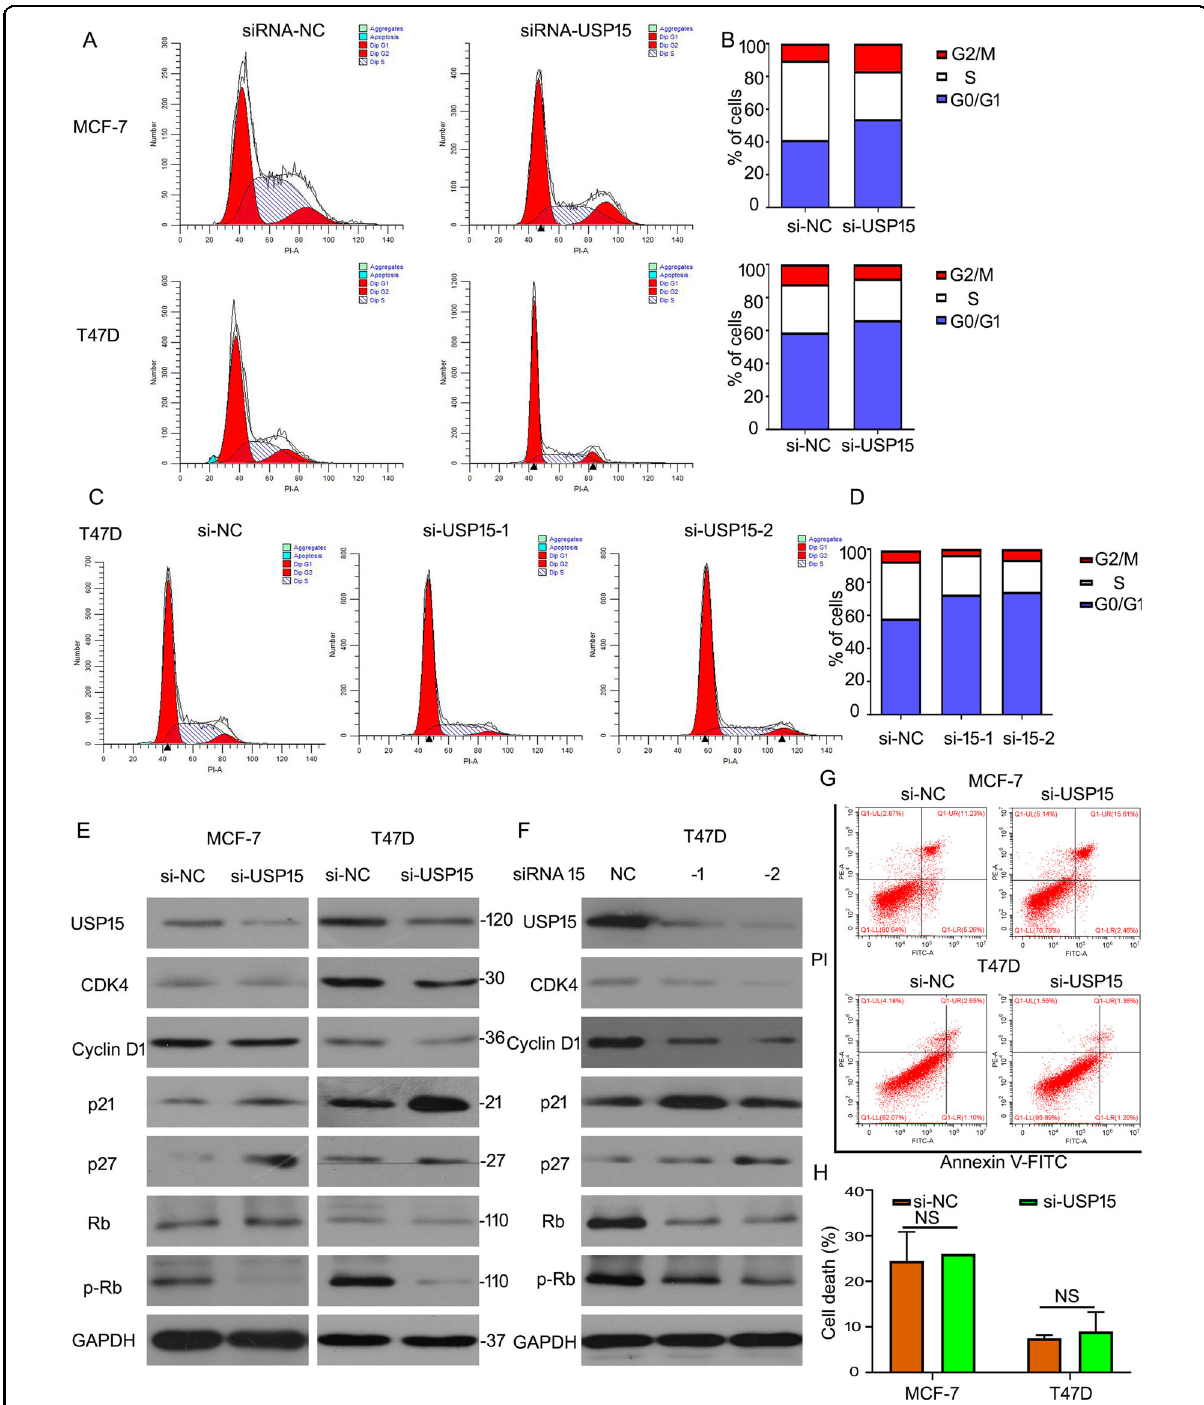
Fig. 2 USP15 deletion triggers cell cycle arrest in ER α + BC cells. A , C Cells were exposed to USP15 siRNA targeting different sets for 48 h, subjected to FACS for cell distributions. B , D The percent of cell number on each phase was showed. E , F Cells were treated with USP15 siRNA, proteins were collected for USP15, CDK4, Cyclin D1, Rb, p-Rb, p21, and p27 expression. GAPDH was as a normalizer. G The same treated cells were tested using fl ow cytometry for apoptotic cells and H the pooled data has been shown. NS is no signi fi